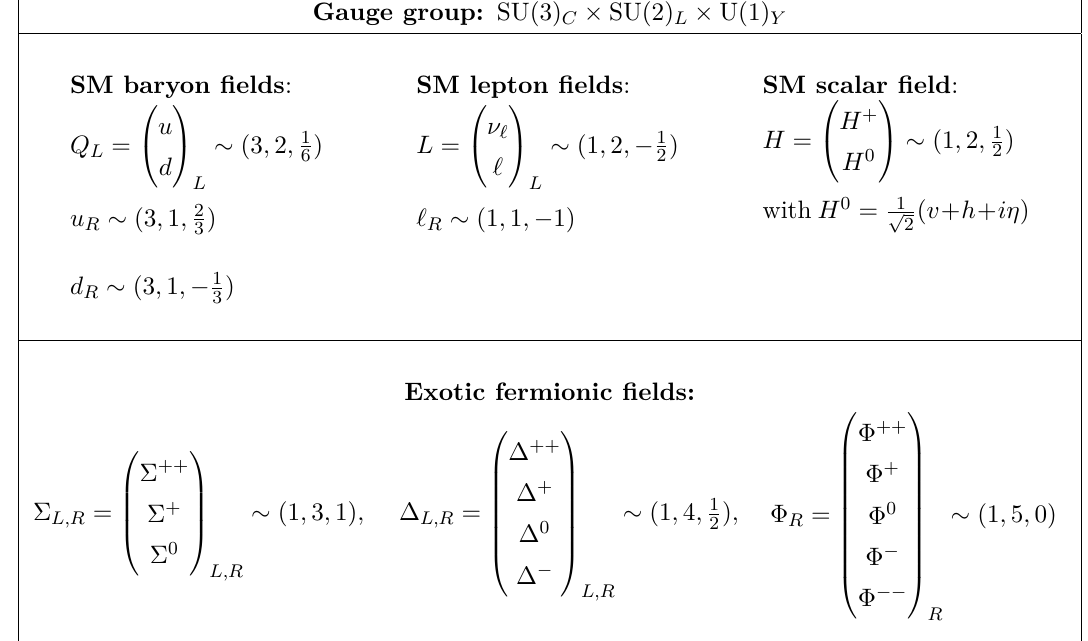
Table 1 . Particle contents of the model with their gauge quantum numbers. Superscripts of the fields denote the corresponding electric charges. We adopt the convention Q = T ation indices are suppressed for the sake of brevity, and will be suppressed throughout this